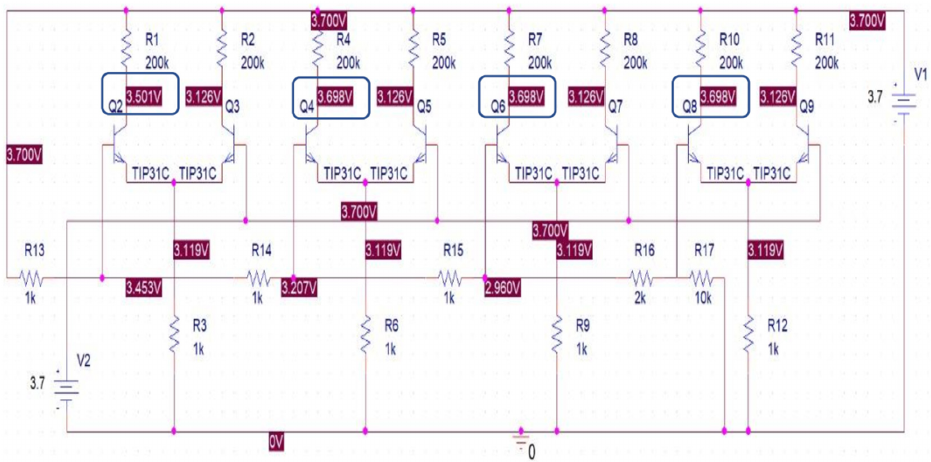
Figure 15. Receiver Circuit Simulation for 3.7 V input.